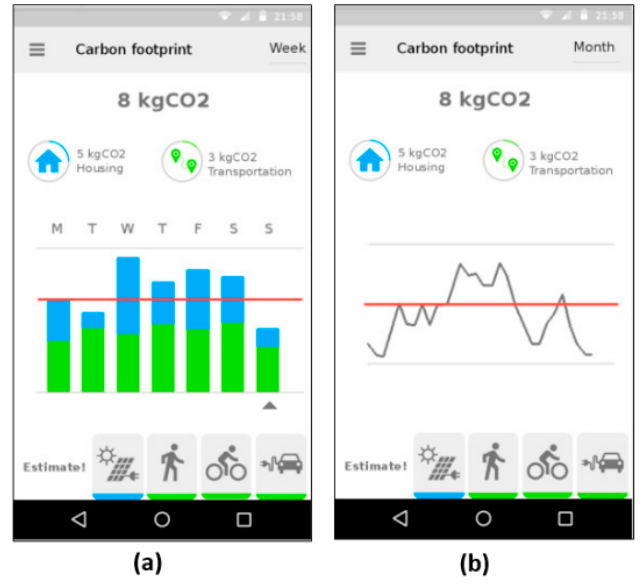
Figure 5. Smiling Earth—CO 2 emissions data visualisation. ( a ) shows CO 2 for a week and ( b ) shows CO 2 emissions for a month.